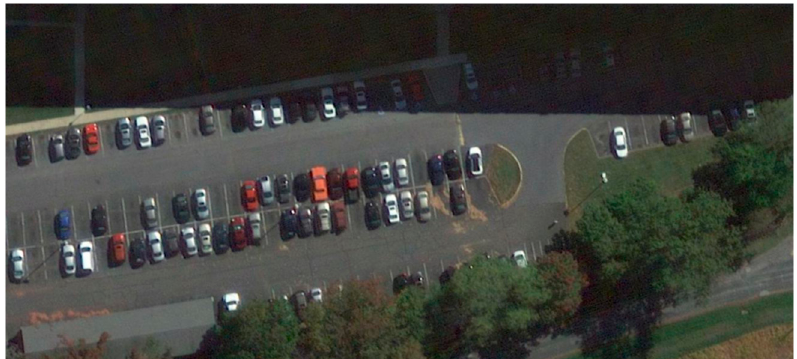
Figure 10. Examples of cars in the UCAS-AOD data set.